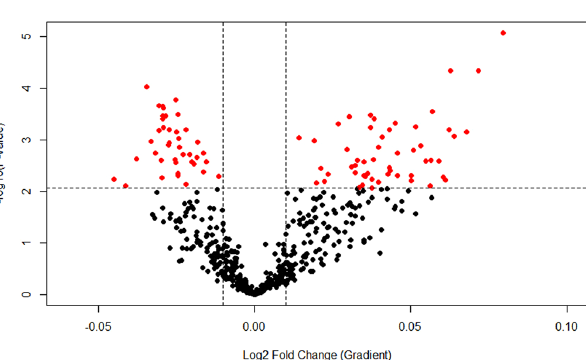
Figure 2. Volcano plot representing all identified miRNAs. For each miRNA identified in this study the volcano plot shows th e fold change (gradient of the association with the cumulative Z-Score) against the –log P value. Statistically significant associated miRNAs are depicted as red